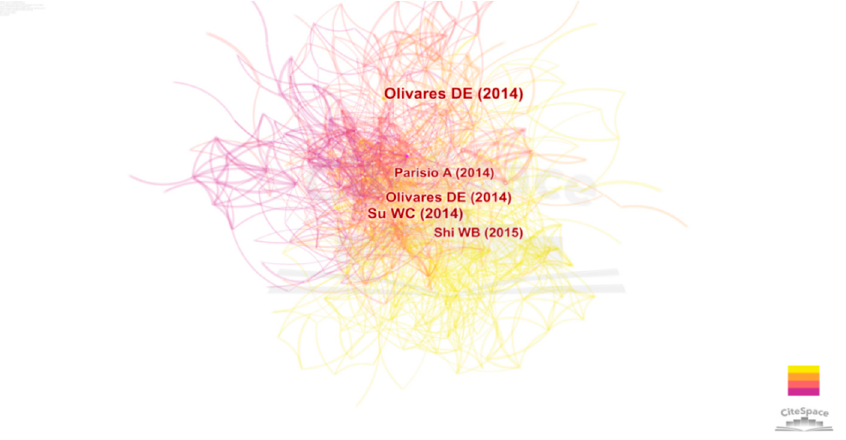
Figure 10. Co-citation network of authors (timespan: 2014–2021; slice length = 2; g-index = 25; LRF = 3; LBY = 5; e = 1; n = 437; E = 1940).